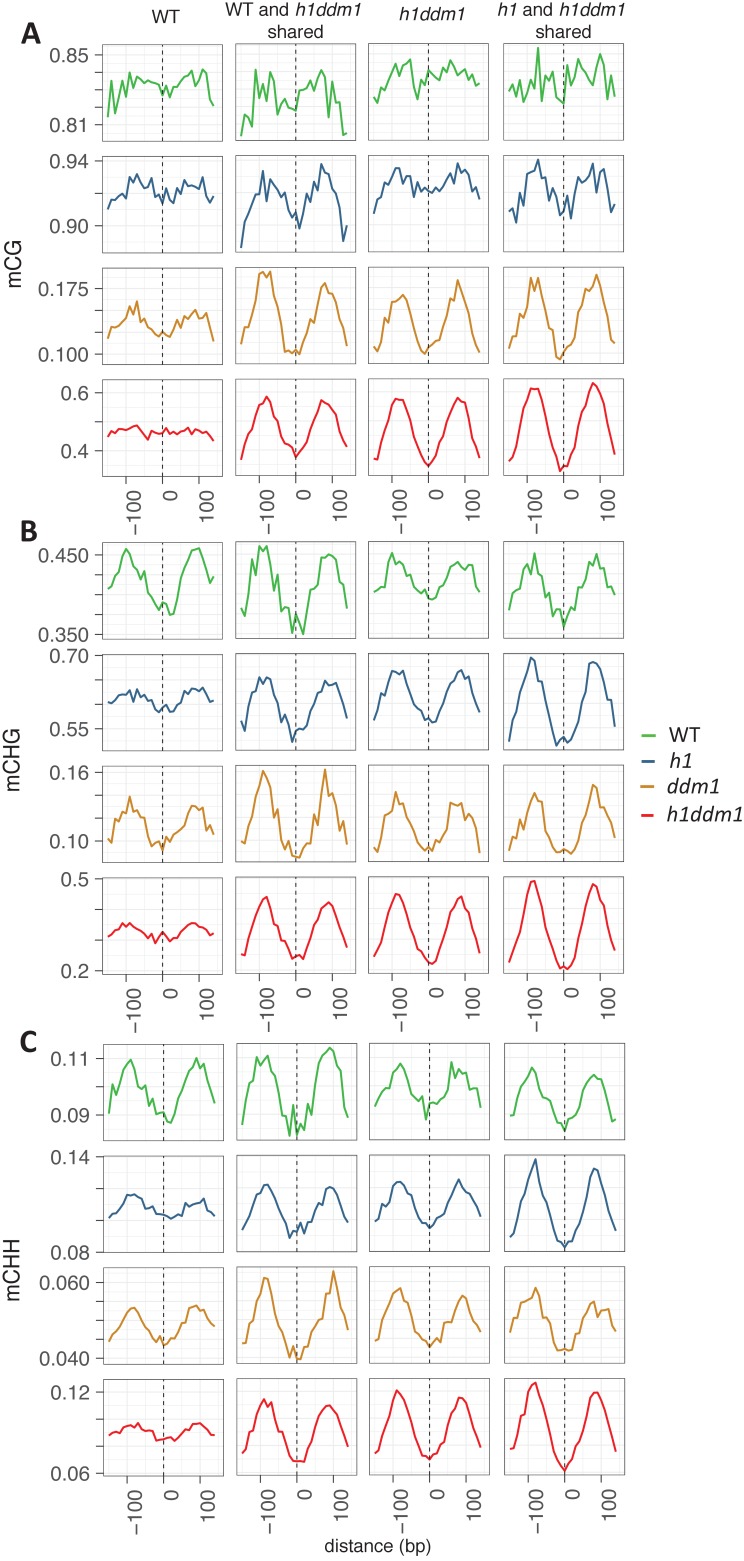
Well-positioned nucleosomes shared across genotypes exhibit nucleosome core depletion and linker enrichment.All WT well-positioned nucleosomes (left column) were used to anchor methylation for mCG (A), mCHG (B), and mCHH (C). WT and h1ddm1 shared well-positioned nucleosomes, h1ddm1 only, and shared h1 and h1ddm1 well-positioned nucleosomes were also used for anchoring methylation in the given contexts. Note that use of all WT well-positioned nucleosomes largely prevents the detection of the nucleosome core depletion phenotype in the mCG context. Also note that Y-axis scales vary between genotypes. Nucleosome numbers: 19122 for WT, 4267 shared by WT and h1ddm1 (22.3% of WT), 22745 for h1ddm1, 6364 shared by h1 and h1ddm1 (28.0% of h1ddm1).